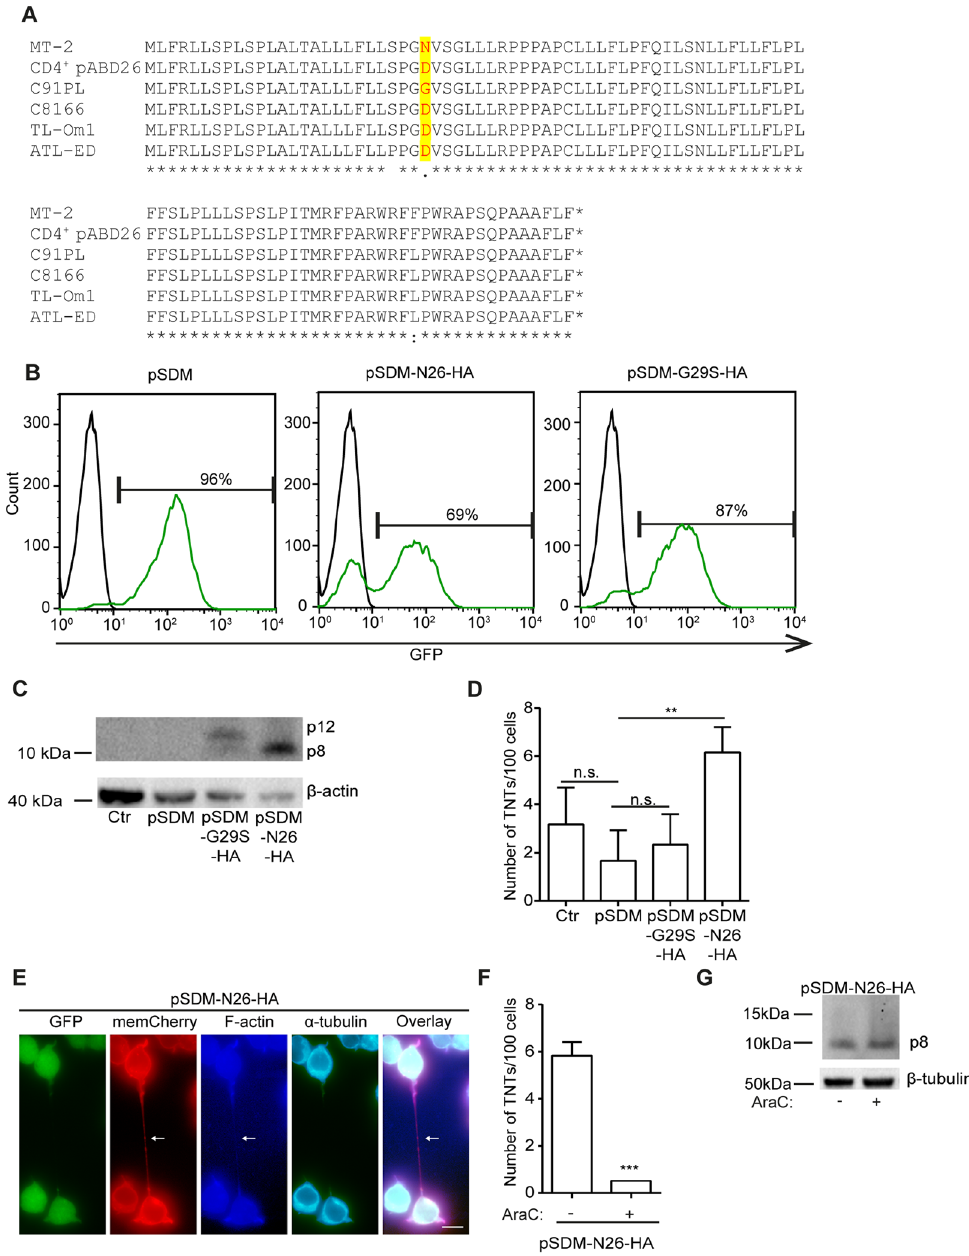
Figure 7. The p8 protein increases TNT formation. ( A ) Orf-I amino acid sequences of HTLV-1 positive cell lines. ( B ) Transduction efficiency determined by flow cytometry of percentage GFP positive cells in Jurkat-memCherry cells transduced with pSDM, pSDM-N26(p8)-HA or pSDM-G29S(p12)-HA. ( C ) Immunoblotting of Jurkat- memCherry cells (ctr), Jurkat-memCherry; pSDM, pSDM-G29S-HA and pSDM-N26-HA incubated with anti-HA antibody. β -actin was used as loading control. ( D ) TNT quantification of Jurkat-memCherry; pSDM, pSDM- G29S-HA and pSDM-N26-HA. Results are presented as mean from three independent experiments performed in duplicates. ( E ) TNT verification in Jurkat-memCherry-pSDM-N26-HA cells. The cells were fixed and stained with AF350 phalloidin to visualize F-actin (blue) and anti- α -tubulin to visualize tubulin (cyan, AF633), transduced cells are GFP positive, plasma membrane memCherry (red). Scale bar: 10 µ m. Result is representative of three independent experiments. ( F ) Jurkat-memCherry-pSDM-N26-HA cells were untreated or treated with 1 µ M cytarabine (AraC) for 24 h and TNTs were quantified in live cells. Results are shown as mean from three independent experiments performed in duplicates. ( G ) Immunoblotting of Jurkat-memCherry-pSDM-N26-HA cells not treated or treated with 1 µ M AraC incubated with anti-HA antibody. β -tubulin was used as loading control. Representative blot of three independent experiments is shown. Unpaired t-test was performed to evaluate statistic significance. F-test was performed for individual variation. GraphPad Prism (Version 6.03) was used ( ** p < 0.01, *** p ≤ 0.001). Full-length immunoblots are presented in Supplementary Fig. 5. Adobe photoshop CS6 was used to prepare the images. The contrast was enhanced on the whole image to better represent and visualize the thin TNT